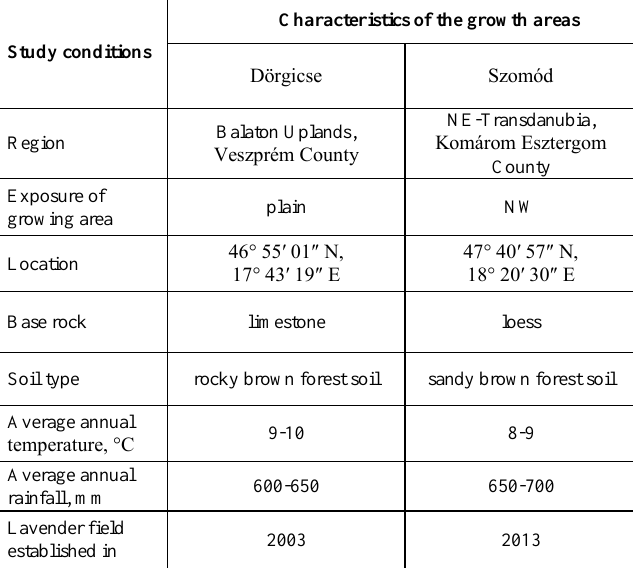
Table 1/a. Environmental conditions of the growing areas